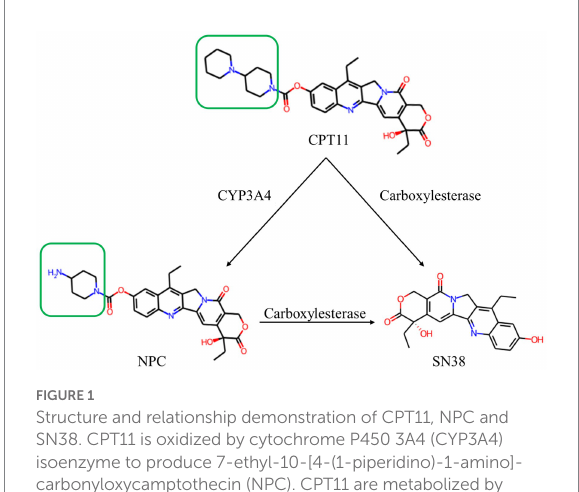
FIGURE 1 Structure and relationship demonstration of CPT11, NPC and SN38. CPT11 is oxidized by cytochrome P450 3A4 (CYP3A4) isoenzyme to produce 7-ethyl-10-[4-(1-piperidino)-1-amino]- carbonyloxycamptothecin (NPC). CPT11 are metabolized by carboxylesterases (CES) to produce active metabolite,